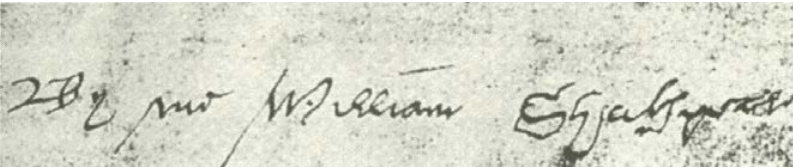
Fig. 6 – Signature n. 6 on page 3 of Shakespeare’s Last Will